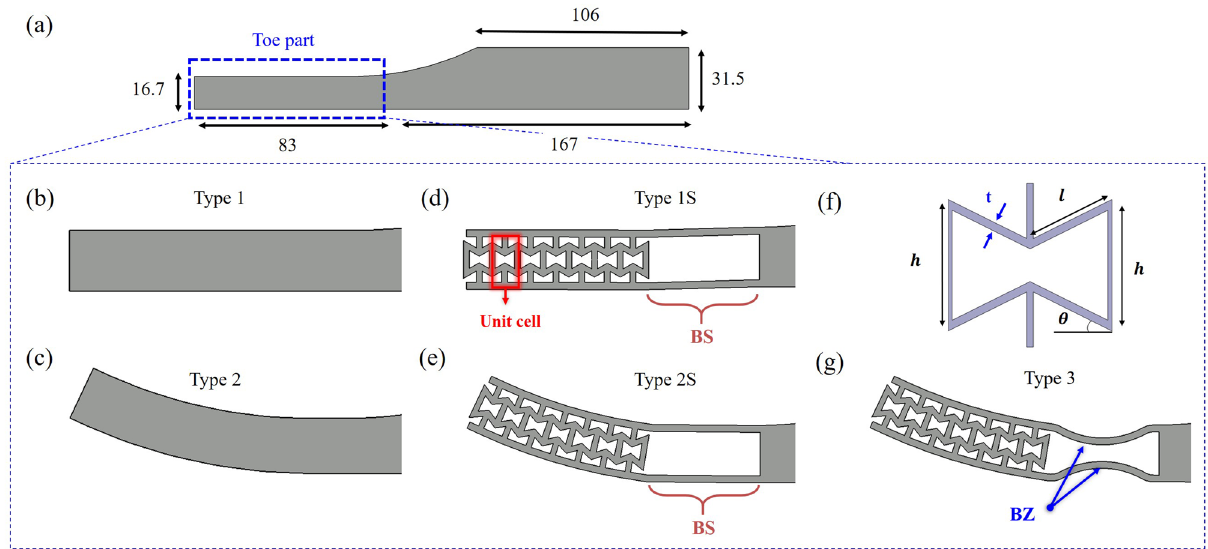
Figure 2. ( a ) Geometry and dimensions of prosthetic foot which was used in simulation. Various toe shape of prosthetic foot to implement toe joint to the prosthetic foot; ( b , c ) without structure and ( d , e , g ) with structure. ( f ) Geometry parameters of unit